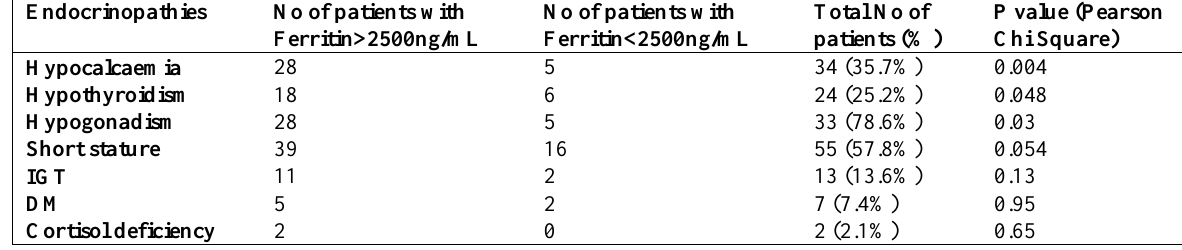
Table 2: Comparison of prevalence of endocrinopathies between those with serum ferritin above 2500ng/mL and below 2500ng/mL among thalassemia patients attending to Teaching Hospital Batticaloa, Sri Lanka.